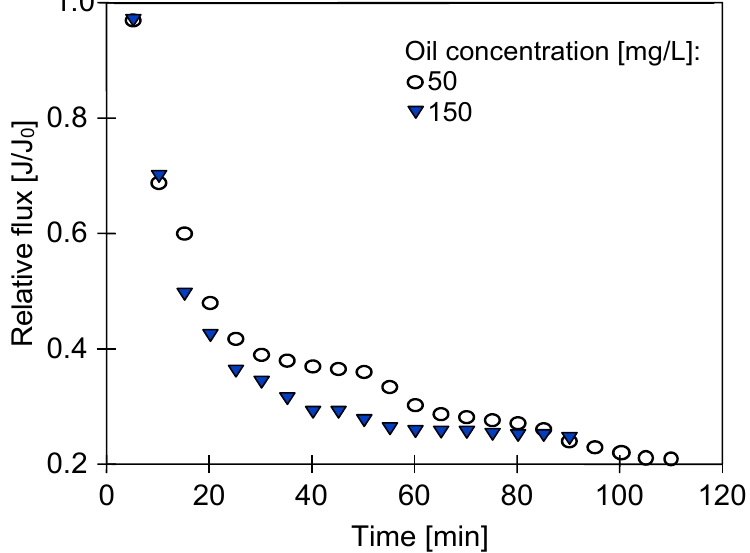
Figure 5. Effect of oil concentration on the permeate flux during MF of model oily emulsions. Module MF1, V F = 0.5 m/s, TMP = 0.05 MPa, T = 22 °C.